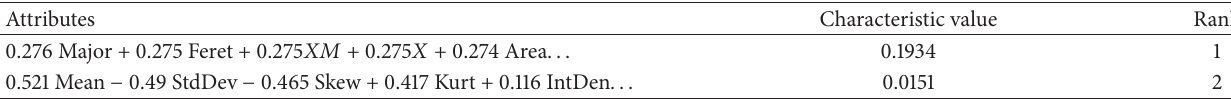
Table 10: PCA ranked attributes. Attributes Characteristic value